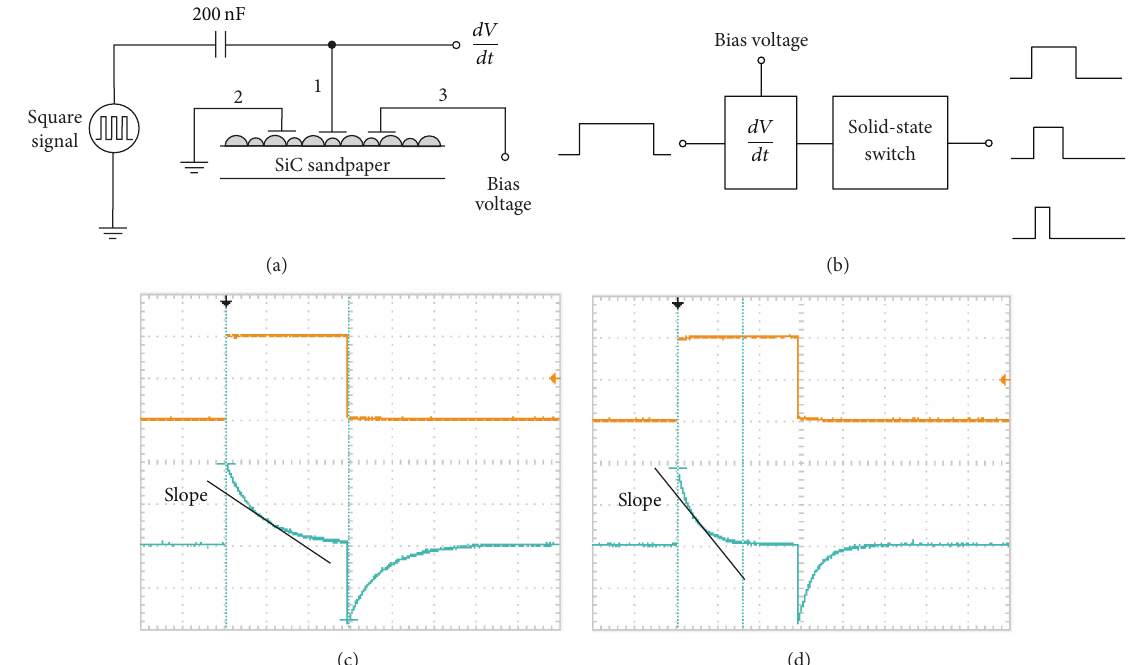
Figure 5: (a) Practical circuit implemented for derivative of a signal. (b) Block diagram to realization of a PWM circuit based on graphite architectures. (c) Derivative of a signal without bias voltage. (d) Derivative of a signal with bias voltage.